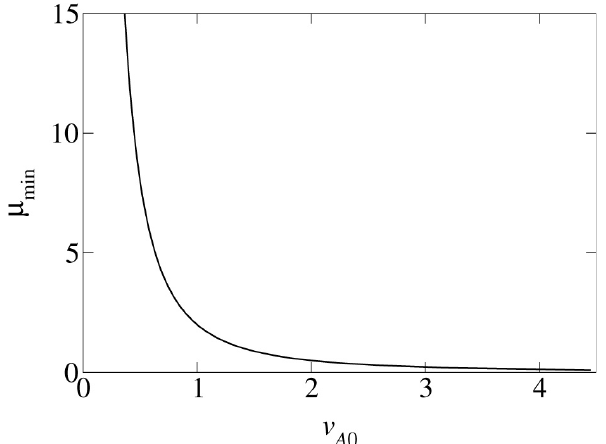
Fig. 9. Minimum value of µ as a function of v A 0 .